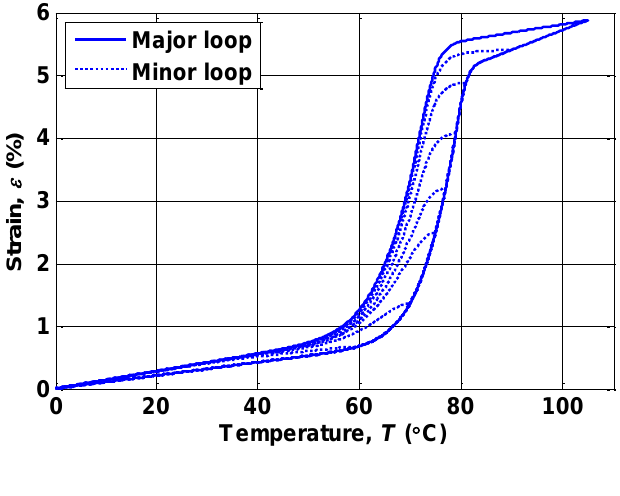
Figure 8. Simulated hysteresis characteristics of SMA